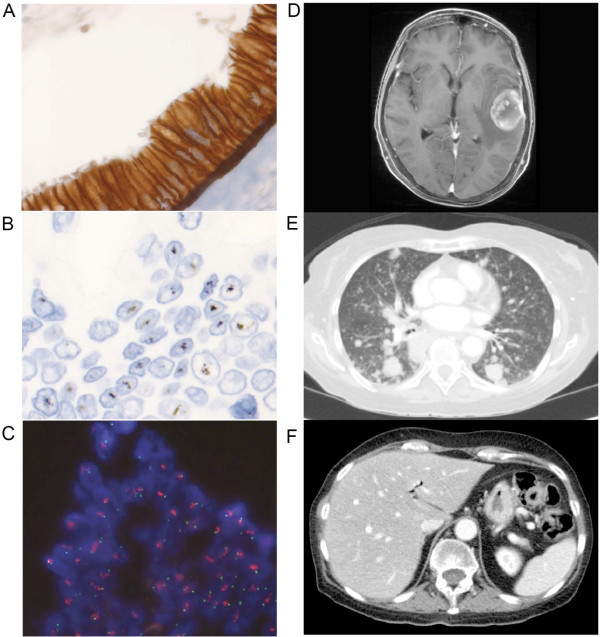
Clinicopathological features of HER2-amplified pancreatic ductal adenocarcinoma (PDAC). (A) Her2 immunohistochemistry showing 3+ staining, and corresponding HER2 amplification on (B) silver and (C) fluorescence in situ hybridization. Imaging results of patient 9 (Table 2) showing (D) cerebral and (E) lung metastases, and (F) absence of liver metastases.